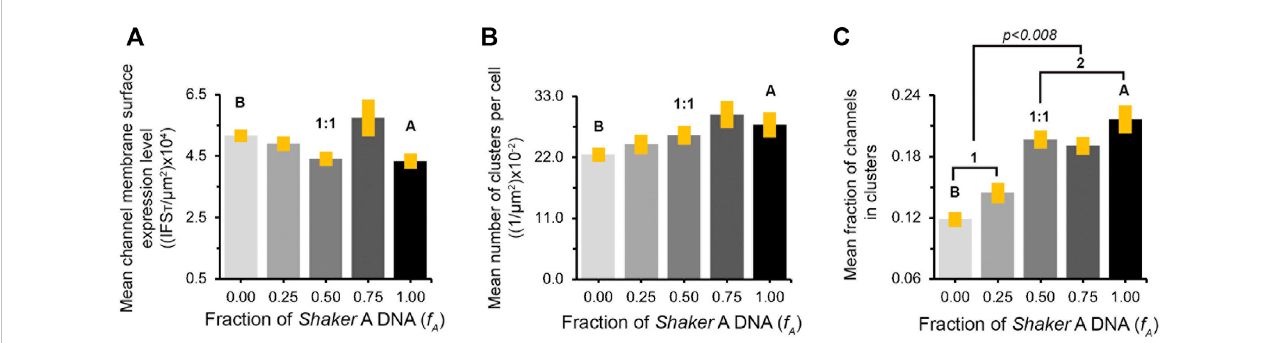
FIGURE 5 Similar channel cell surface expression patterns appear at all A : B subunit transfection ratios. (A) Comparison of mean channel membrane surface expression levels in cells transfected to express different concentration ratios of the A and B Kv channel subunit variants and the PSD-95 scaffold protein. Channel membrane surface expression levels are re fl ected in the integrated channel-associated red fl uorescence signal within the cell (IFS T ), normalized to cell area. (B) Comparison ofthe meannumber ofclusters per cell (normalized to cell area) incells transfected to express the different A : B subunitvariant transfection ratios and the PSD-95 scaffold protein. The values in both analyses presented in (A) and (B) were found to be similar, based on multi-variant ANOVA for multiple comparisons. In each case, the p values for all comparisons were higher than 0.03. (C) Comparison of the mean fraction of the A or B Kv channelvariantsorcombinationsthereof(asmodulatedbydifferent A : B transfectionratios),expressedatclusteringsites.Thevalueswereobtainedbydividing the overall channel-associated red signal within cell clustering sites (IFSc) to IFS T . The labels 1 and 2 refer to the two distinct, low and high, IFSc/IFS T groups. See Materials and Methods and the text for details on how these cell-based clustering attributes were